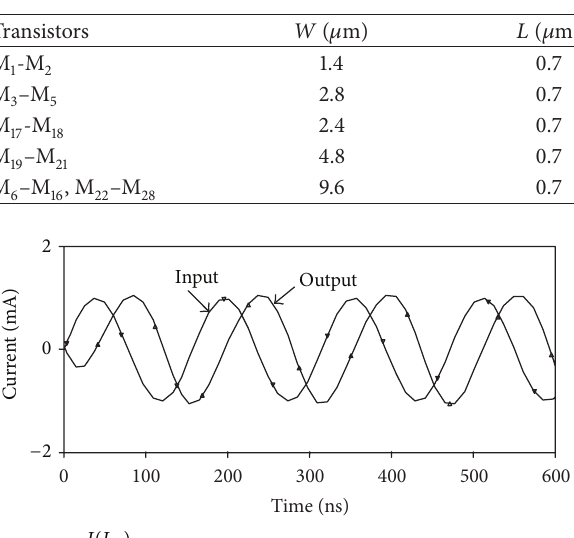
Table 2: Aspect ratios of the transistors.